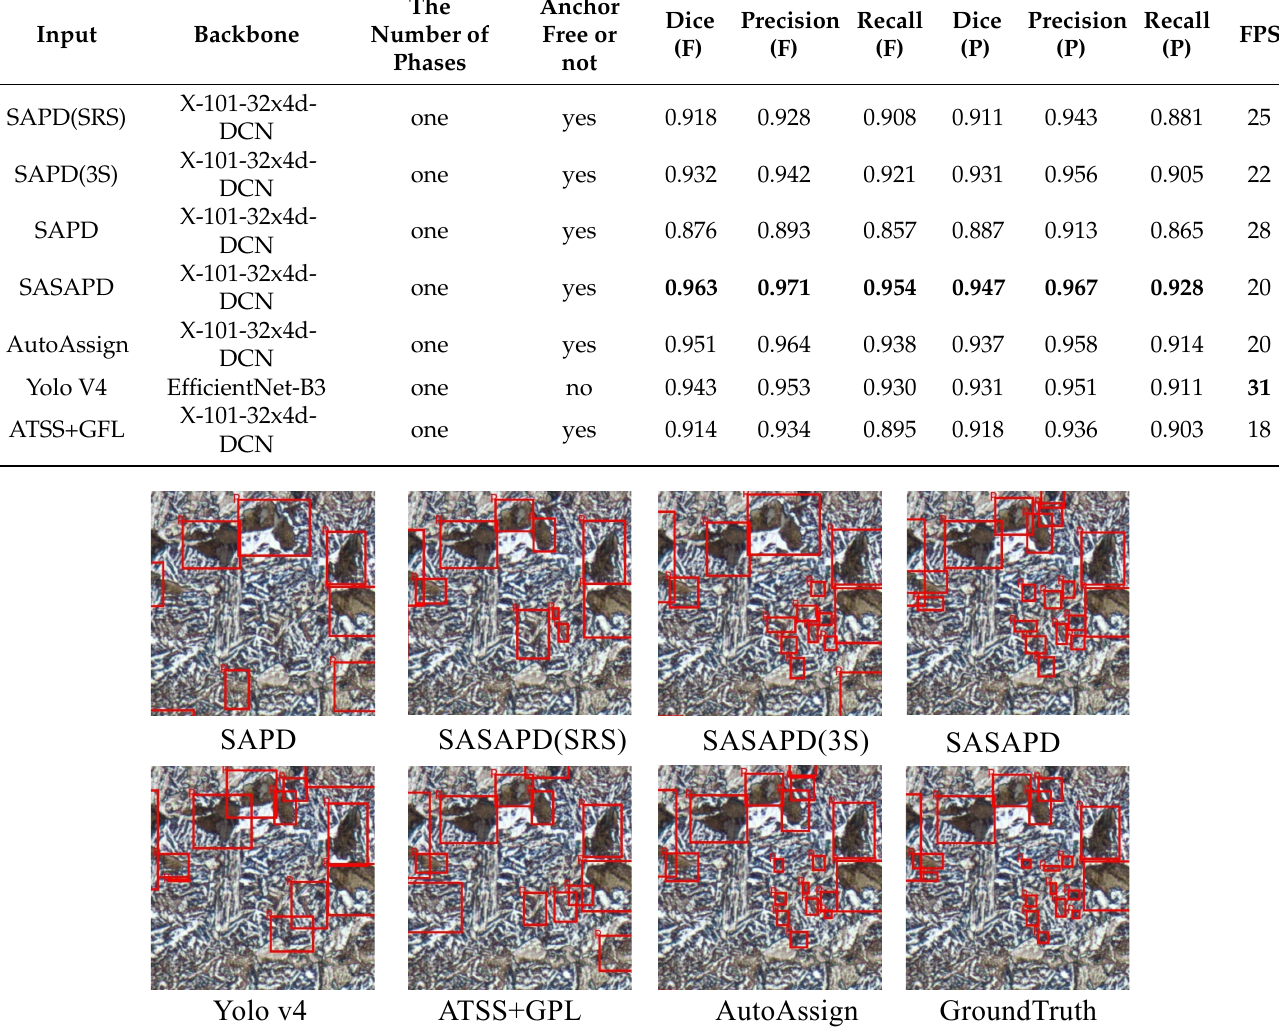
Figure 11. The visual comparison of identifying pearlite (P) on dataset MPMID.